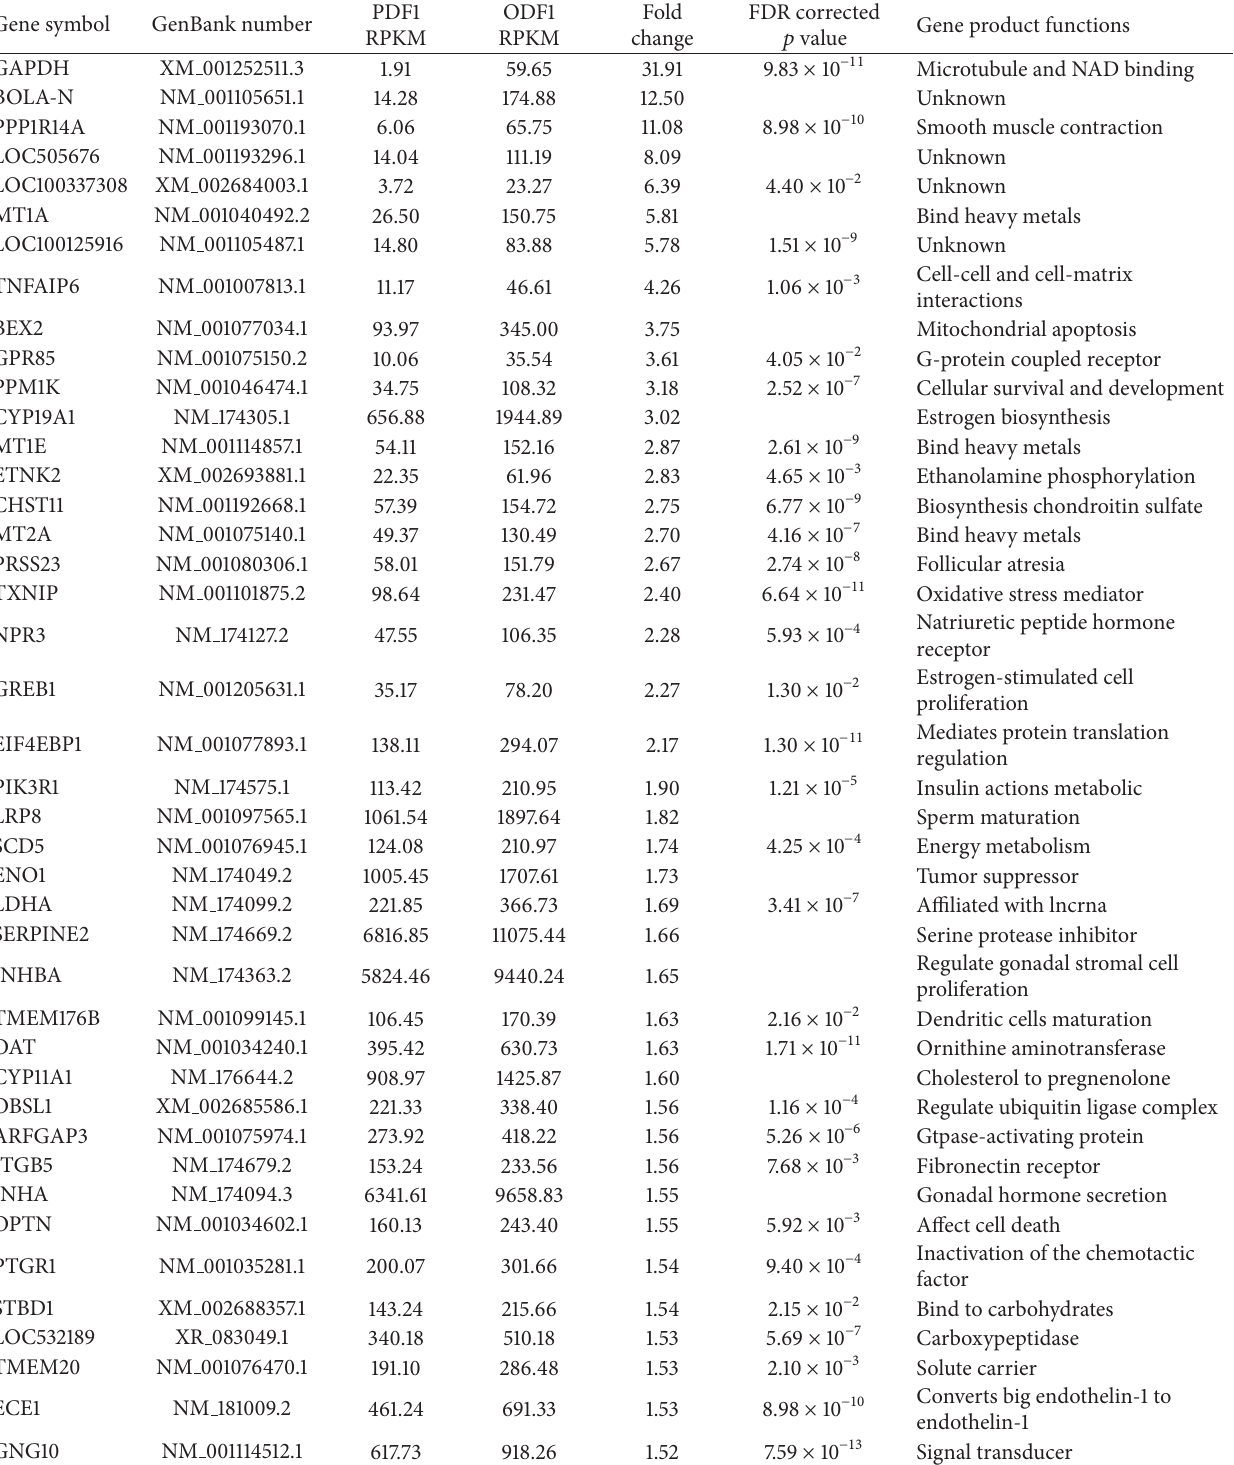
Table 3: List of upregulated genes in ODF1 versus PDF1 and their